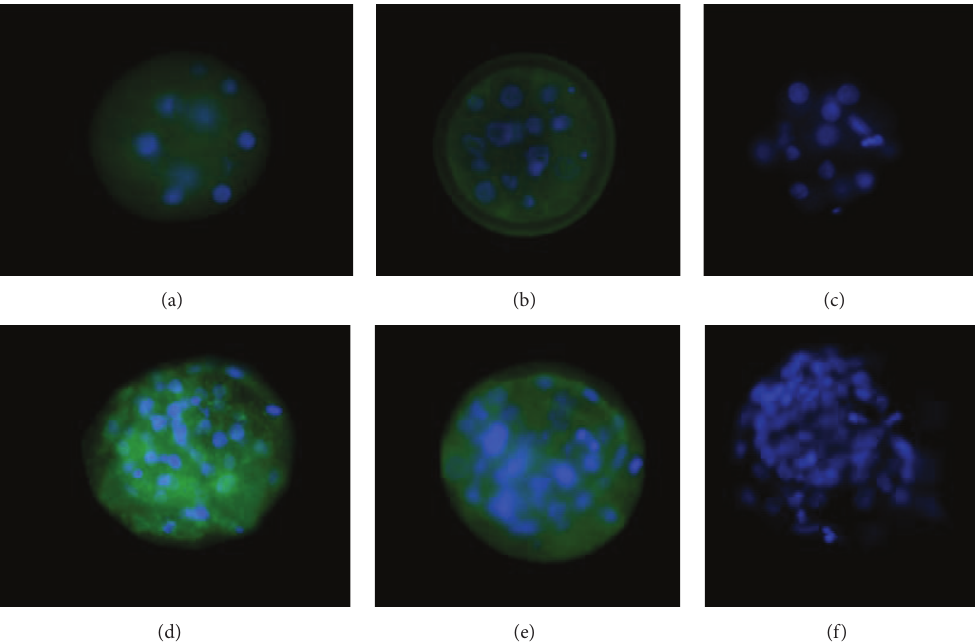
Figure 2: Expression of LPA synthesis enzymes ATX ((a) and (d)) and cPLA 2 ((b) and (e)) in late cleavage (Day 5; upper row) and blastocyst (Day 8; bottom row) stage bovine in vitro produced embryos. (c) and (f) negative controls; 200x magnification.